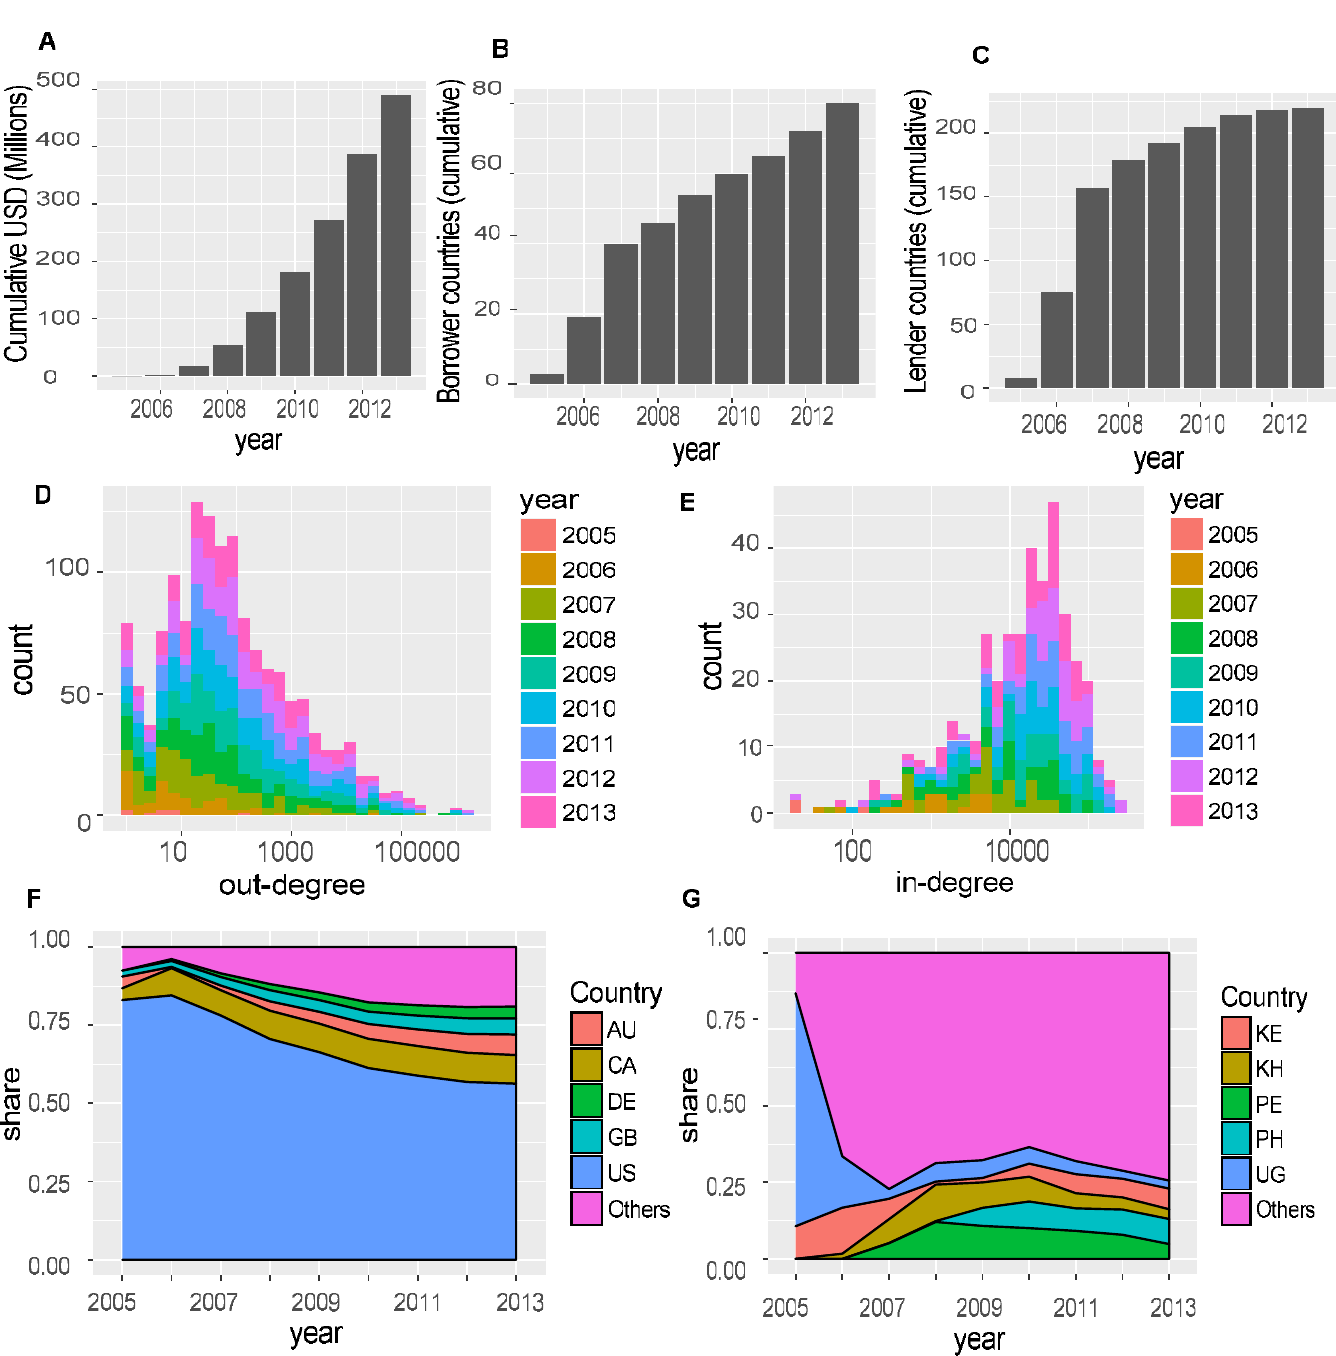
PLOS ONE | https://doi.org/10.1371/journal.pone.0193007 March 28,